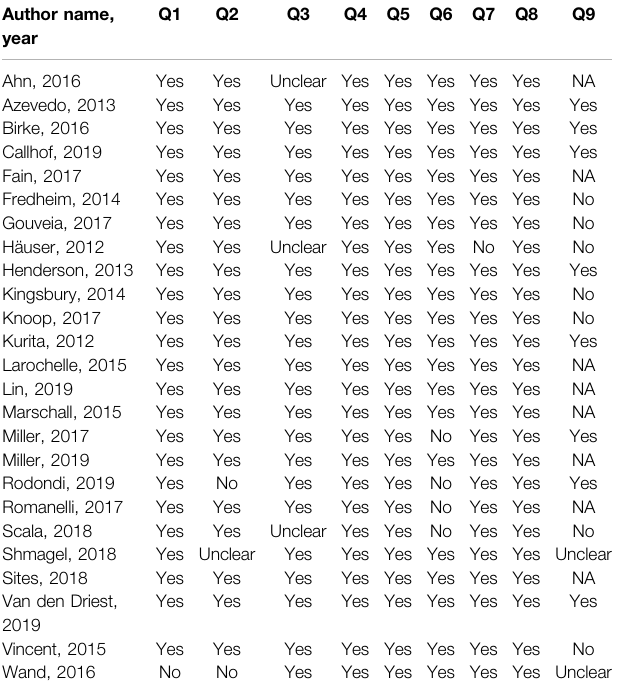
TABLE 1 | Risk of bias assessment. Checklist for studies reporting prevalence data from the Joanna Briggs Institute (N (cid:1) 25). Author name,